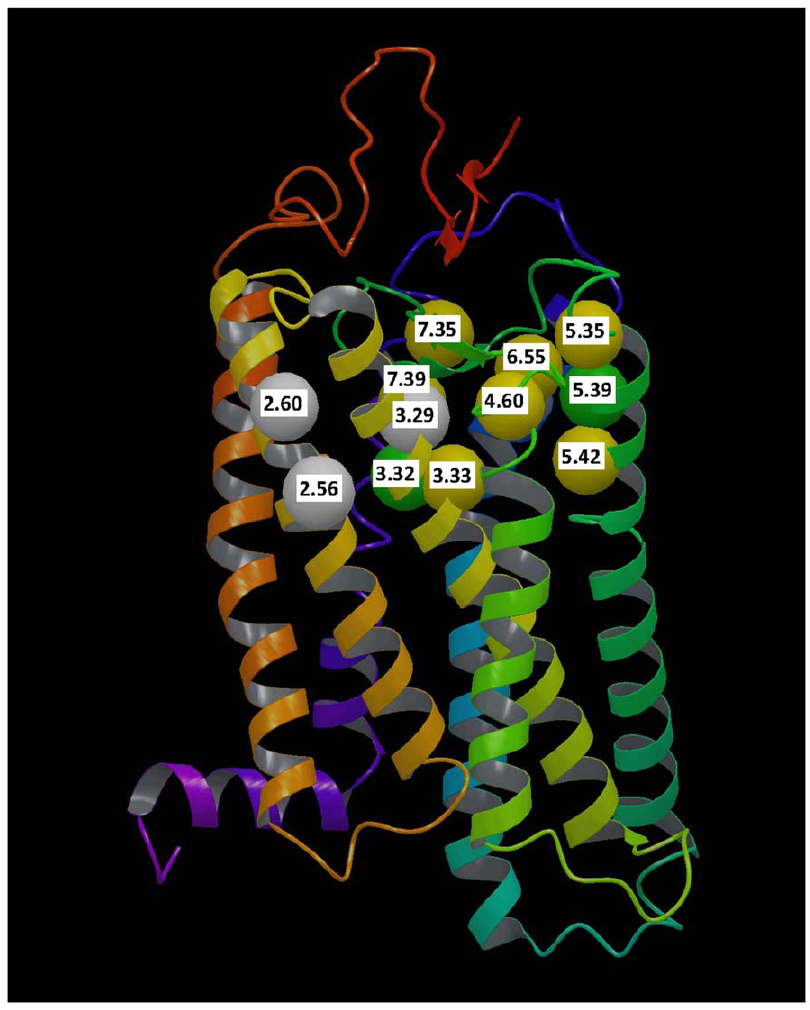
Figure 4. Notable positions of the MRGX1-type receptors visualized in the crystal structure of bovine rhodopsin. Positions 2.56, and 2.60 and 3.29 are under positive selection pressure and shown in white 2 3.29 is a key position, while 2.56 and 2.60 are not. Residues at two key positions, 3.32 and Val 204 5.39 are under negative selection pressure and shown in green. Residues at remaining 7 key positions are not under strong selective pressure are shown in yellow. Those positions are 3.33, 4.60, 5.35, 5.42, 6.55, 7.35 and 7.39. The figure is relative to the structure of bovine rhodopsin published by Schertler and coworkers (PDB ID: 1GZM) [70]. The notable positions are represented through spheres centered on the C a atoms of the corresponding rhodopsin residues. The backbone of the receptor is schematically represented as a ribbon, colored with continuum spectrum that transitions from red to purple moving from the N-terminus to the C-terminus (TM1: dark orange; TM2: light orange; TM3: yellow; TM4: yellow/green; TM5: green; TM6: cyan; TM7: blue/purple). Figure S1 The average v from key positions ( , v key . ) contrasted with average v from randomly selected 7TM positions ( , v random7TM . ). Results of selection pressure, from PAML’s model M7 vs. M8, for subgroups 1–45, as listed in